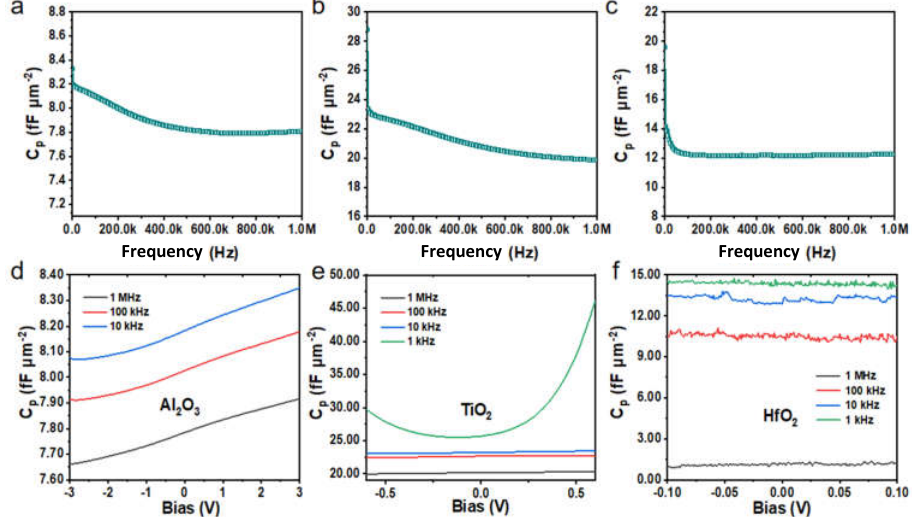
Figure 6. C - Q and C - V characteristic curves of 25 nm Al 2 O 3 , TiO 2 , and HfO 2 dielectric capacitors. ( a – c ) The C - Q characteristic curves of three kinds of 25 nm dielectric capacitors, respectively. ( d – f ) The corresponding C - V characteristic curves of three kinds of 25 nm dielectric capacitors at different